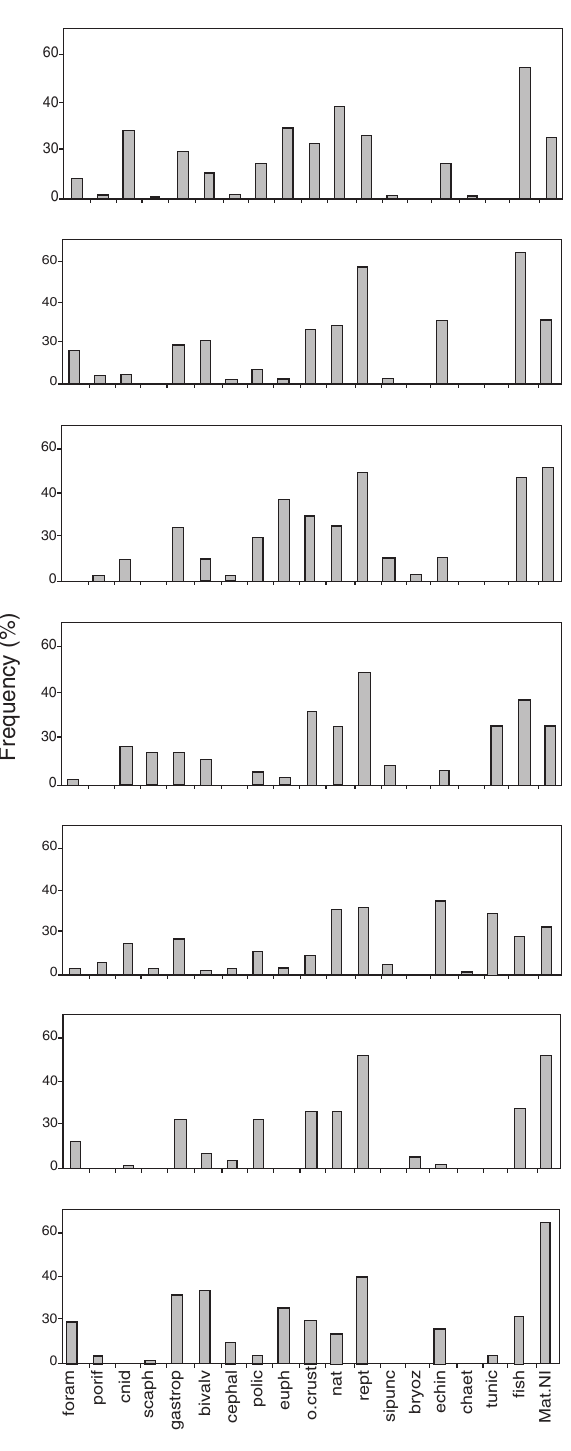
F IG . 1. – Frequency of occurrence of different prey groups in the diet of Nephrops norvegicus for all sites and for the entire study. Abbreviations: Foraminifera - FORAM; Porifera - PORIF; Cnidaria - CNID; Scaphopoda - SCAPH; Gastropoda - GAS- TROP; Bivalvia - BIVALV; Cephalopoda - CEPHAL; Polichaeta - POLIC; Euphausiacea - EUFH; Other Crustaceans -